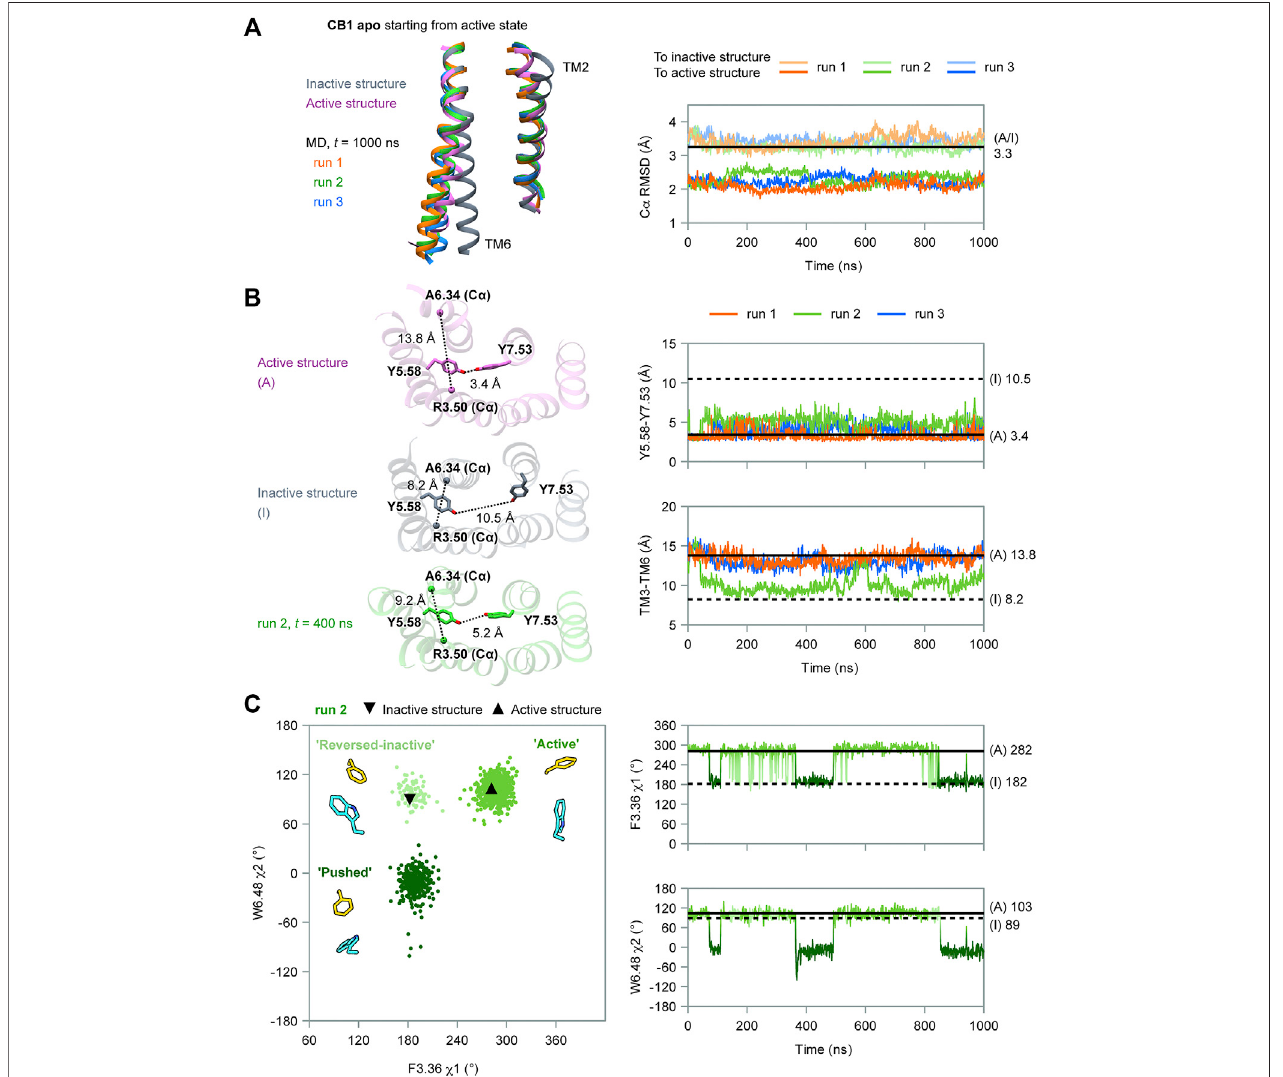
FIGURE 2 | MD simulation results of apo CB1 starting from the active state. (A) Overall structure did not show the trend of deactivation during simulations. Left panel: the ending conformations of the three runs resemble the active structure (only TM2 and TM6 are shown for the sake of clarity). Right panel: root mean square deviations (RMSD) of C α atoms showed CB1 remained more similar to the active structure than to the inactive through the three runs. (A/I) noted for RMSD of C α atoms between the active structure and inactive structure. (B) Run 2 captured movements of the cytoplasmic part. Left panel: indices Y5.58-Y7.53 and TM3-TM6 in inactive structure (I), active structure (A), and representative snapshot in run 2. Right panel: Y5.58-Y7.53 distance remained around the value in (A); TM3-TM6 distance remained around (A) in runs 1 and 3, but varied between (A) and (I) in run 2. (C) Side-chain conformations of F200 3.36 and W356 6.48 in run 2. Left panel: distribution of dihedral angles showed three con fi gurations of F200 3.36 /W356 6.48 , as illustrated by representative snapshots. In the con fi guration “ reversed-inactive, ” the dihedral angleswere close to values in the inactive state, but the positions of the two residues were still the same as in the active state. Right panel: F200 3.36 χ 1 and W356 6.48 χ 2 during simulation (results for runs 1 and 3 are shown in Supplementary Figure S2